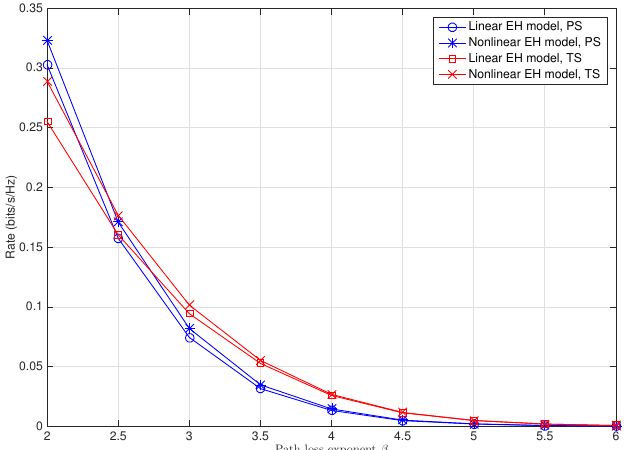
Figure 5. Maximum achievable rate versus the path loss exponent β for SWIPT multi-relay coopera- tive system with PS and TS schemes when P s / N 0 = 20 dB, K R = 0 dB, d sc = 2 m, d cd = 4 m.